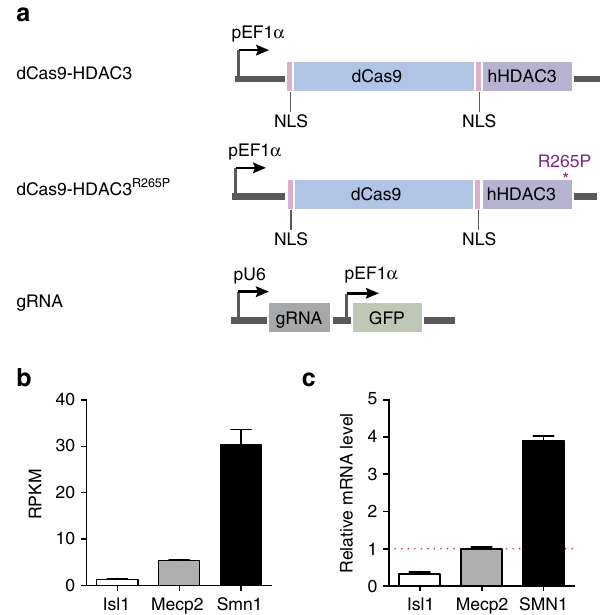
Figure 1 | Design of Cas9-based HDAC system. ( a ) Schematic of